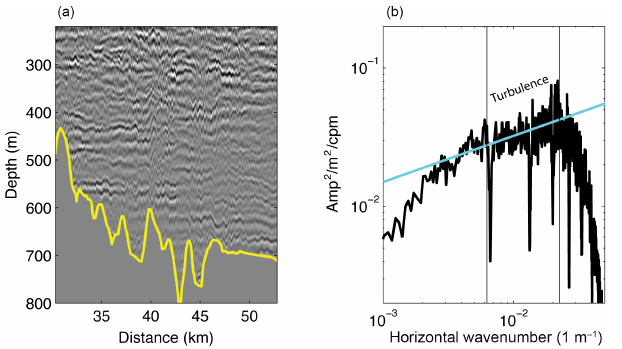
Figure 3. (a) Region of analysis of seismic slope spectra (data trans- form) of Limon1. (b) Spectra of Limon1 matches the characteristic turbulence slope in horizontal wavenumber – slope spectra space over the same wavenumber range as the displacement spectra of Fig. 4 as marked by gray vertical lines. The signal-to-noise ratio here is 5.54. The drop-off at high wavenumbers is due to frequency filtering in the seismic data from 30 to 80Hz.